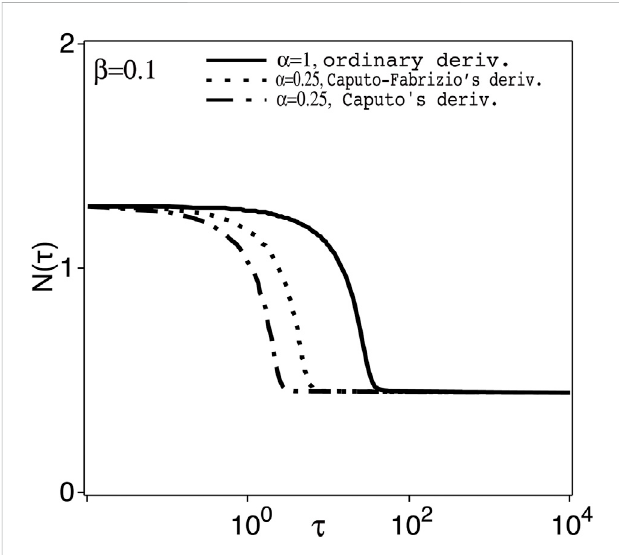
FIGURE 5 Data as in Figure 2, but with negative perturbation, K c − β at A off , where K c